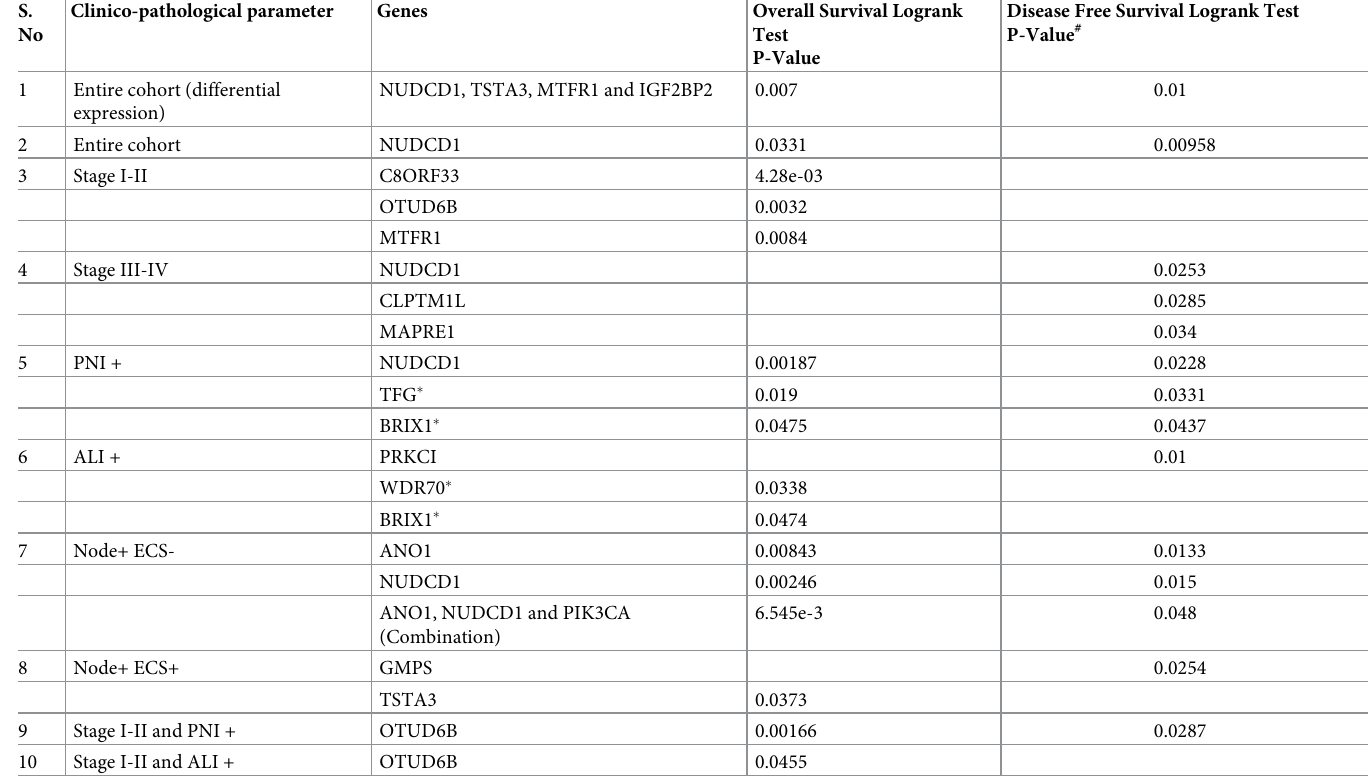
Table 2. Prognosticators of survival (DFS and OS) in patients with tongue cancer in various clinic-pathological parameters. S. Clinico-pathological parameter No